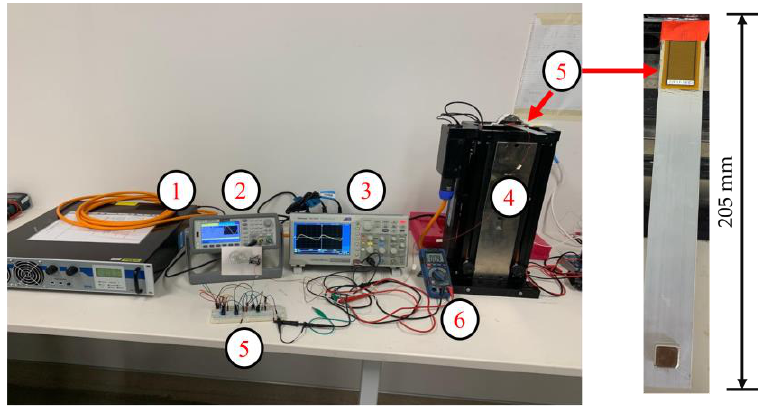
Figure 11. Experimental circuit diagram and experimental setup.